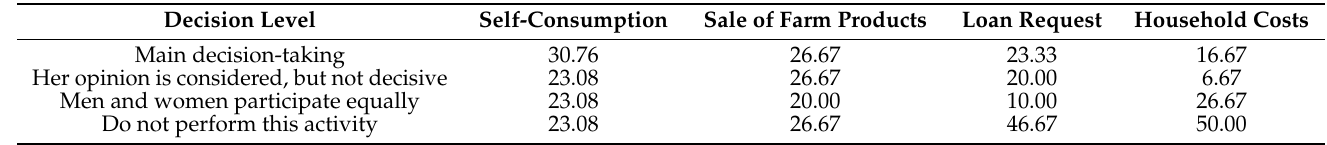
Table 6. Participation of women in the decision-making of dairy goat farms (%). Decision